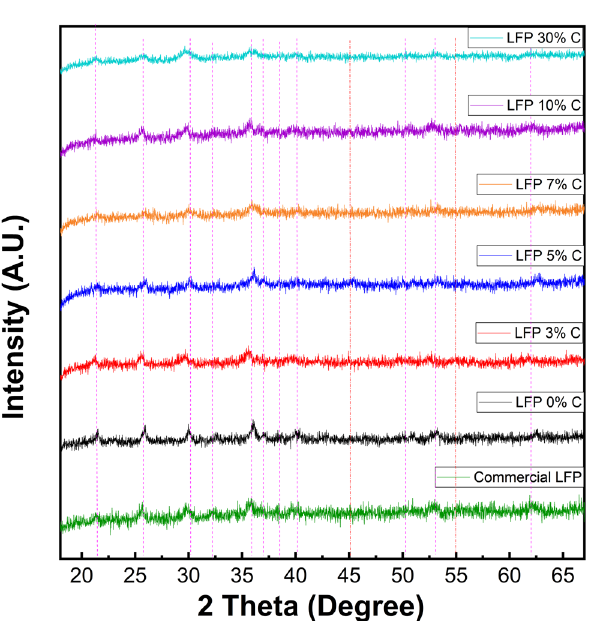
Figure 4: ( a ) Infrared absorption spectra ( FTIR ) of FeC 2 O 4 · 2 H 2 O precursor; ( b ) SEM images of FeC 2 O 4 particle. Figure 5: Results of XRD LiFePO 4